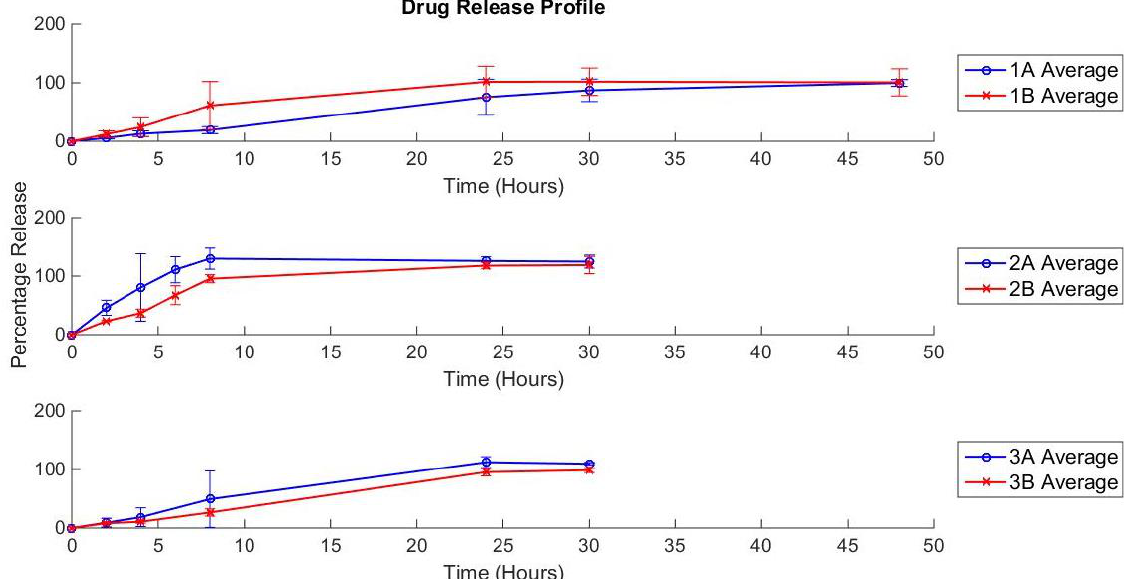
Figure 5. Drug release profiles for all samples. The profile shown is the average for all 3 technical replicates. 100% drug release assumed 5 wt% and 10 wt% (sample A and B respectively) loading of